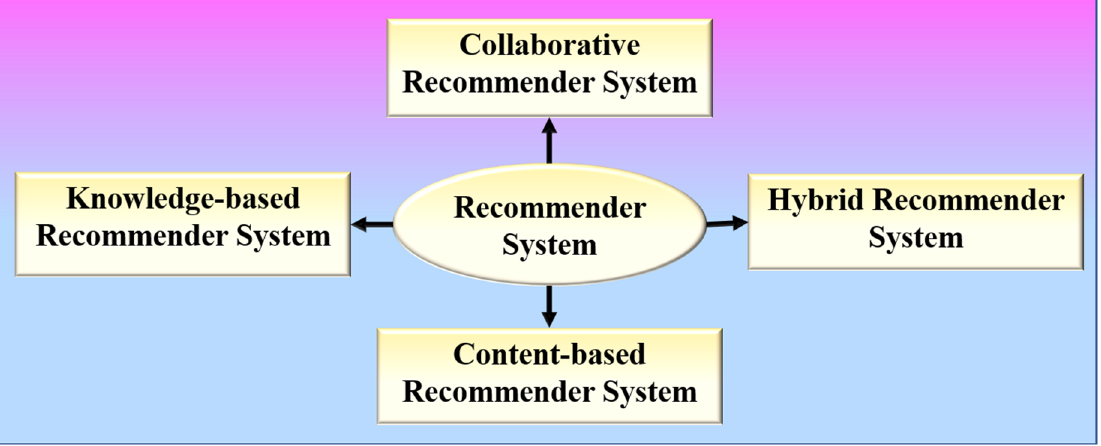
Figure 3. Various types of recommender systems.